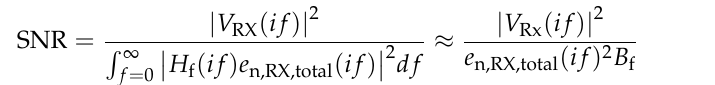
(cid:12) (cid:12) Figure 11: (cid:12) is high, which subsequently leads to a low impedance Z Sensor,trns (cid:12) Z RX,trns